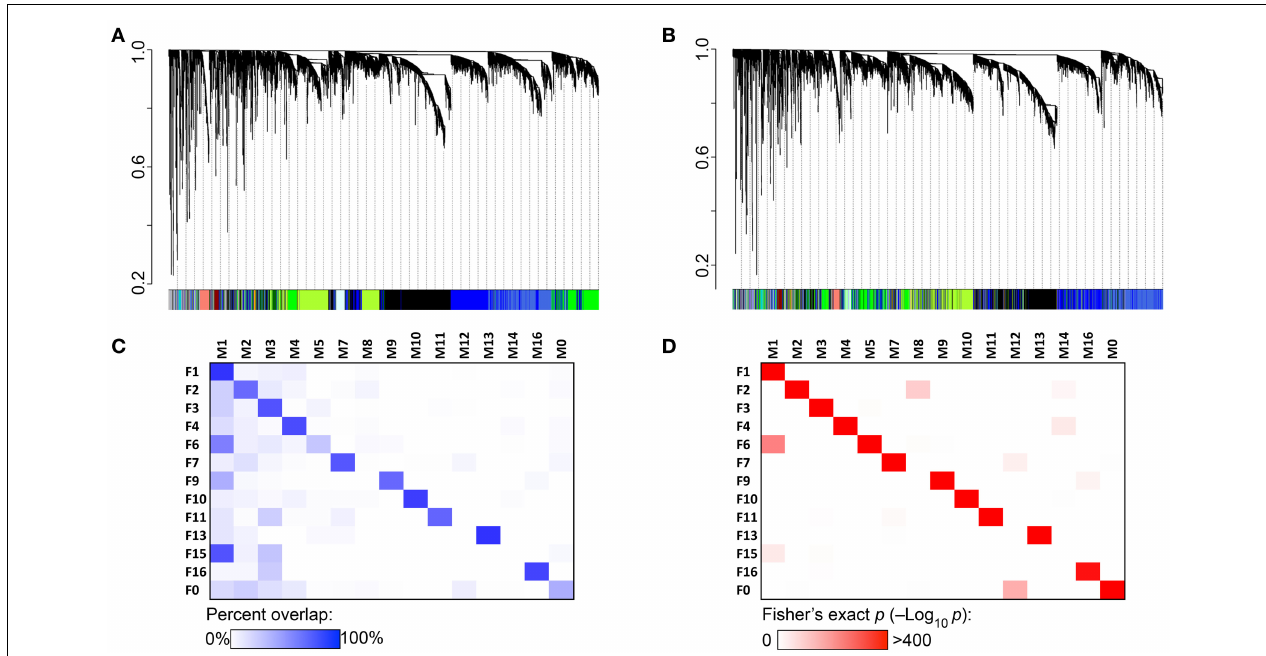
shows that transcripts that cluster together in females generally cluster together in males. (C) There is 60–80% overlap between female and corresponding male modules. Corresponding modules are designated by the same label number, e.g., F1, F2 in females (row labels), and M1, M2 in males (column labels).Transcripts that do not fall into any coexpressed module are categorized to F0 and M0. (D) Significance level of network preservation is provided by the Fisher’s exact test ( − log 10 p